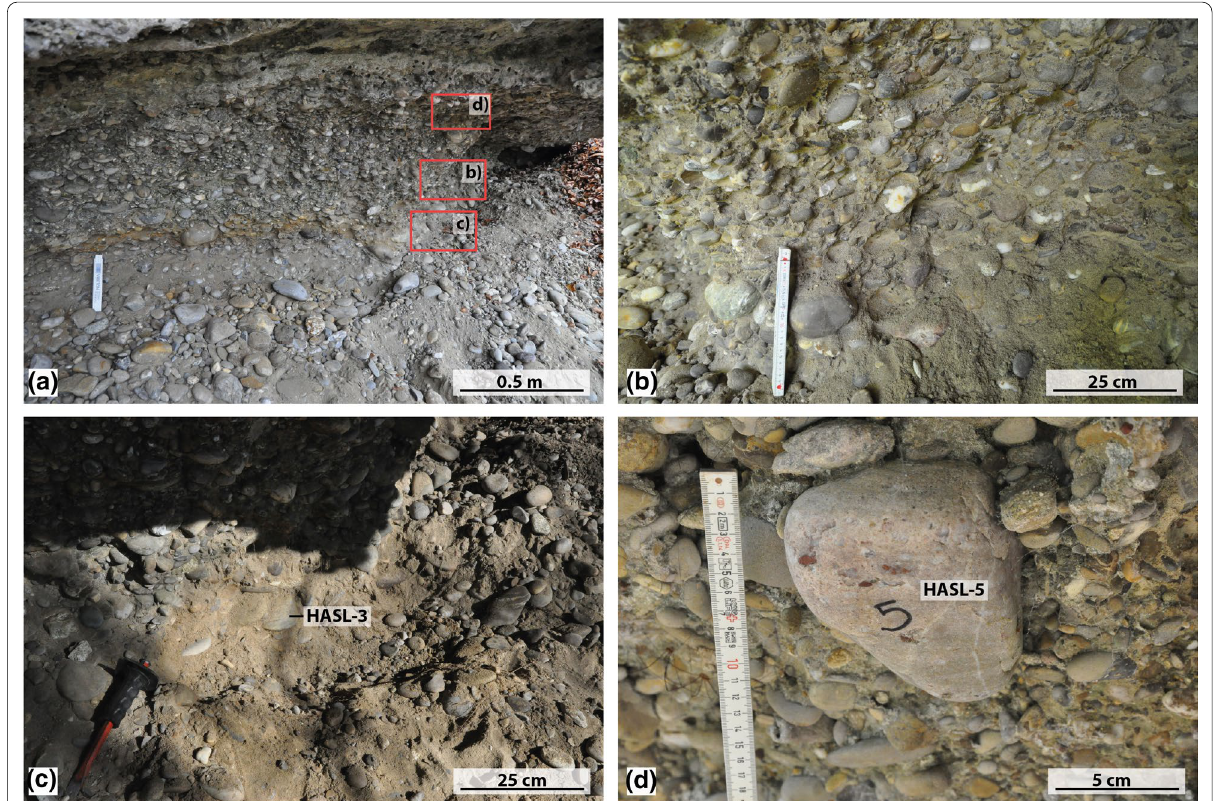
Fig. 6 Field photographs from the Hasli site. a Overview of the outcrop and indicating the positions of photographs b , c , and d . b Close-up photograph of the Steig Gravel at Hasli showing the poor sorting and the sandy to silty matrix. c Photograph of the sample HASL-3. d Photograph of the sample